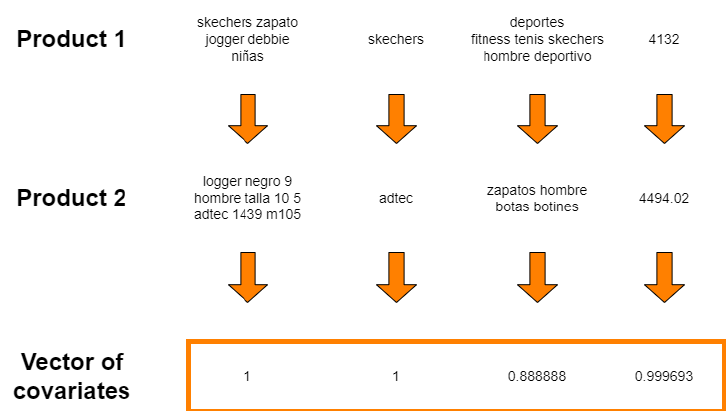
Figure 10. Vector of covariates for the labeled tuples used in our CML algorithm Our CML classification algorithms are based on logistic regression, SVMs, naive Bayes, k − nearest neighbors, and random forest, using the default settings implemented in the Scikit-learn Python module